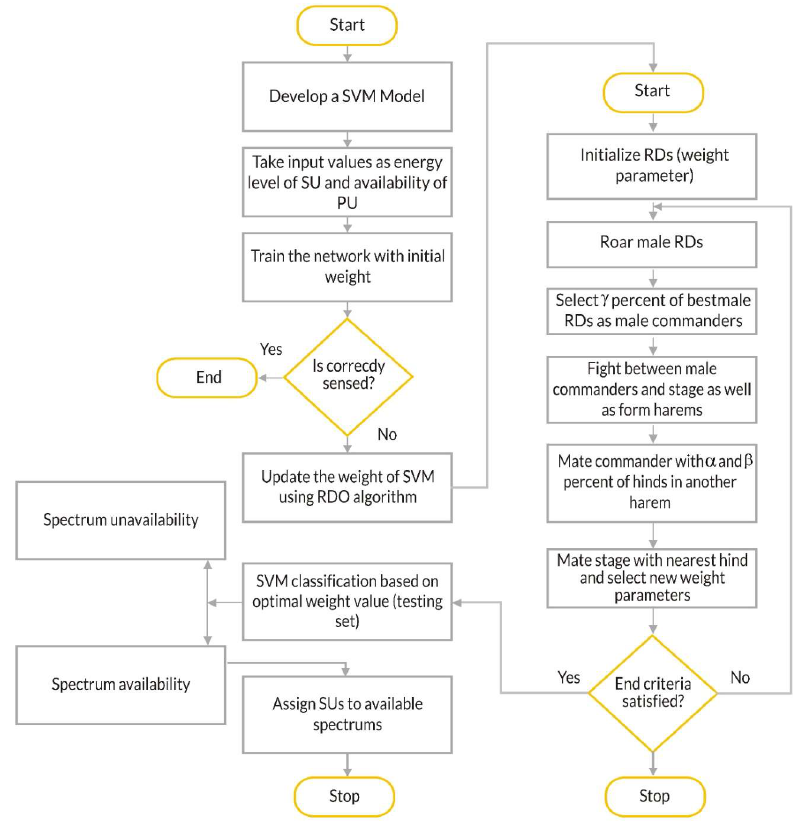
Figure 2. Flowchart of SVM-RDA.